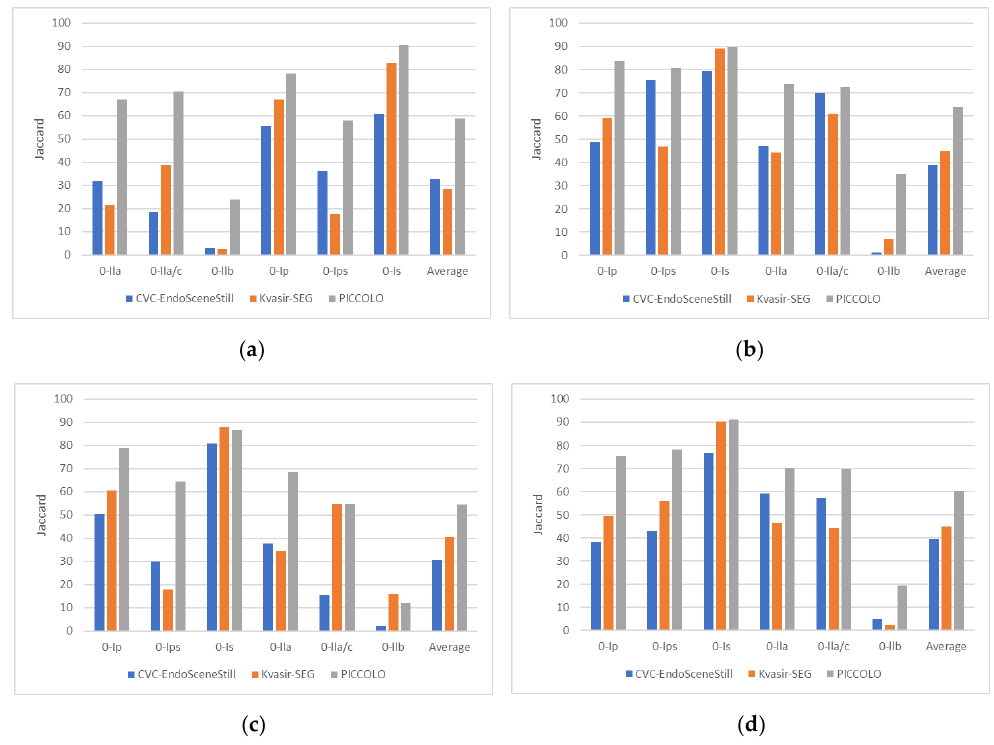
Figure 4. Jaccard index reported on the test set of the PICCOLO dataset for the four models. Each series represents the model trained with the corresponding dataset ( a ) U-Net + VGG16; ( b ) U-Net + Densenet121; ( c ) LinkNet + VGG16; ( d ) LinkNet + Densenet121.